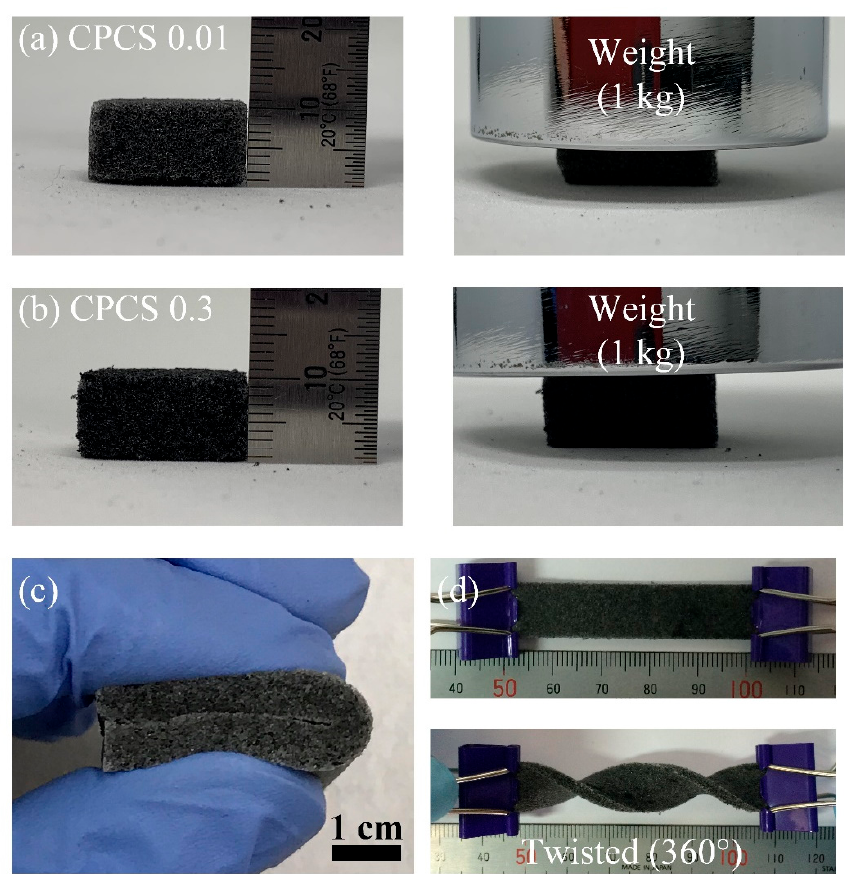
Figure 4. Photos captured before and after loading of a weight of 1 kg on the hexagonal-shaped ( a ) CPCS 0.01, and ( b ) CPCS 0.3. ( c ) Fully folded band-like CPCSs. ( d ) Non-twisted and twisted (360°) CPCSs.